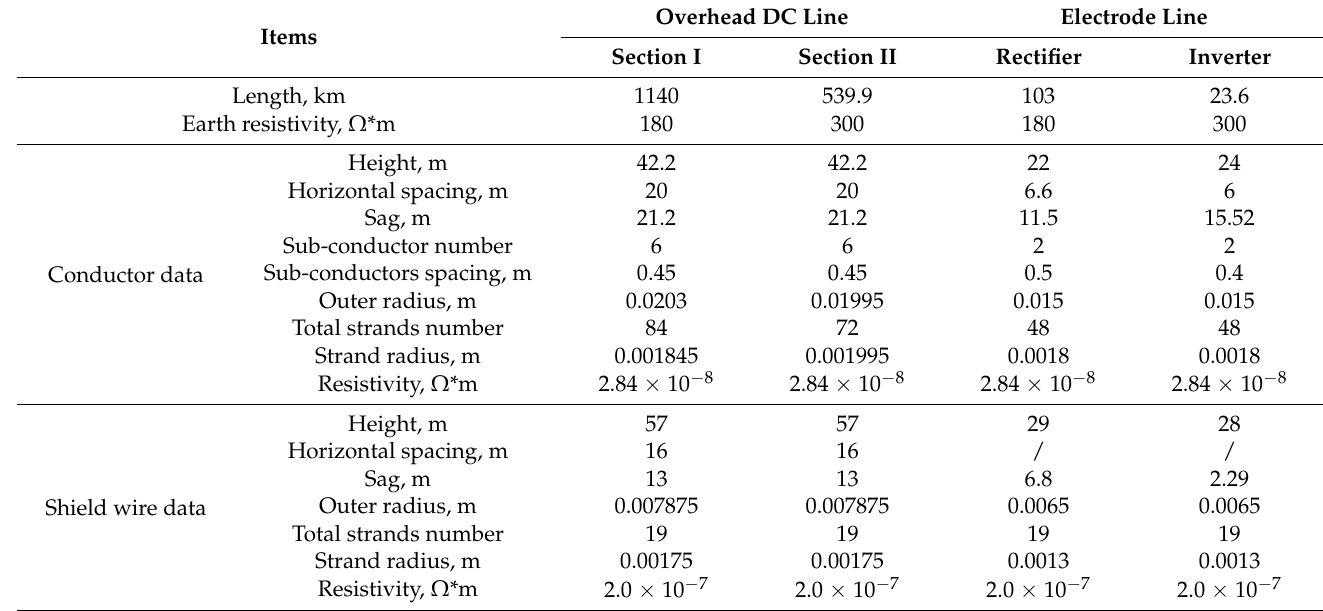
Table 3. Transmission line parameters.